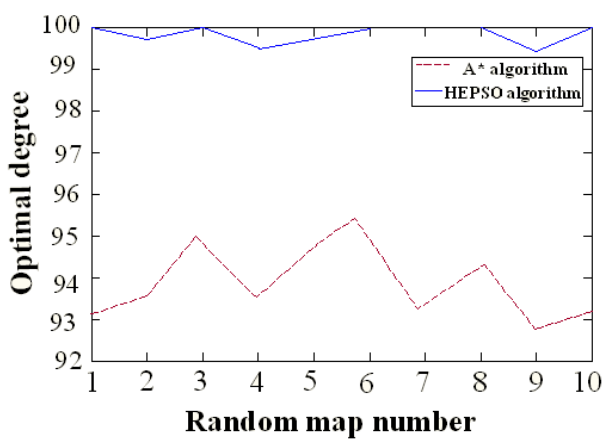
Figure 5. Comparison of optimal degrees of A* and HEPSO algorithms on random obstacles maps.